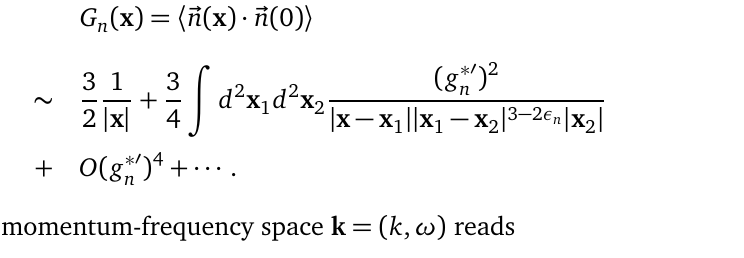
) . As long as the initial value g v